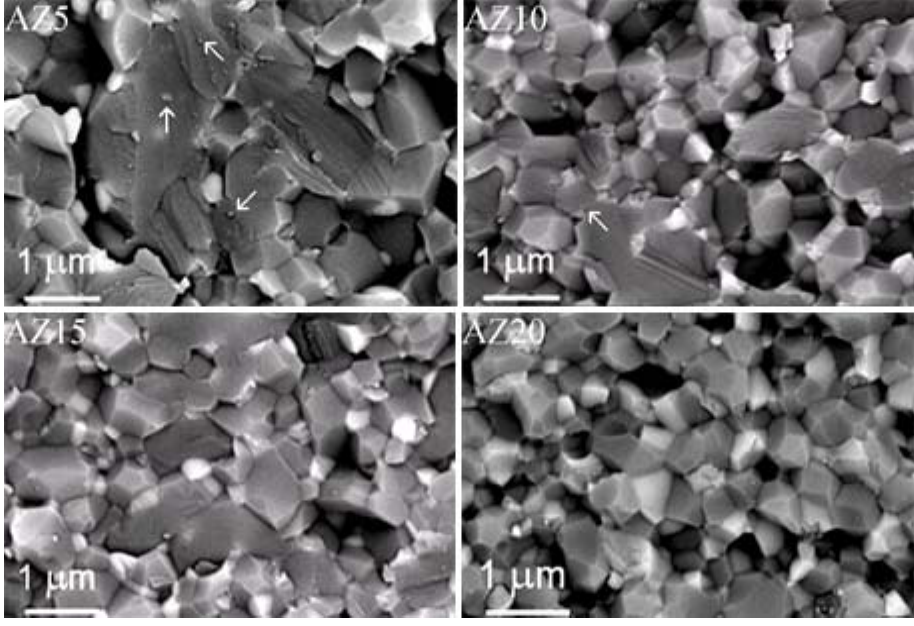
Figure 8. ESEM images of the fracture surface of AZ sintered materials obtained by slip